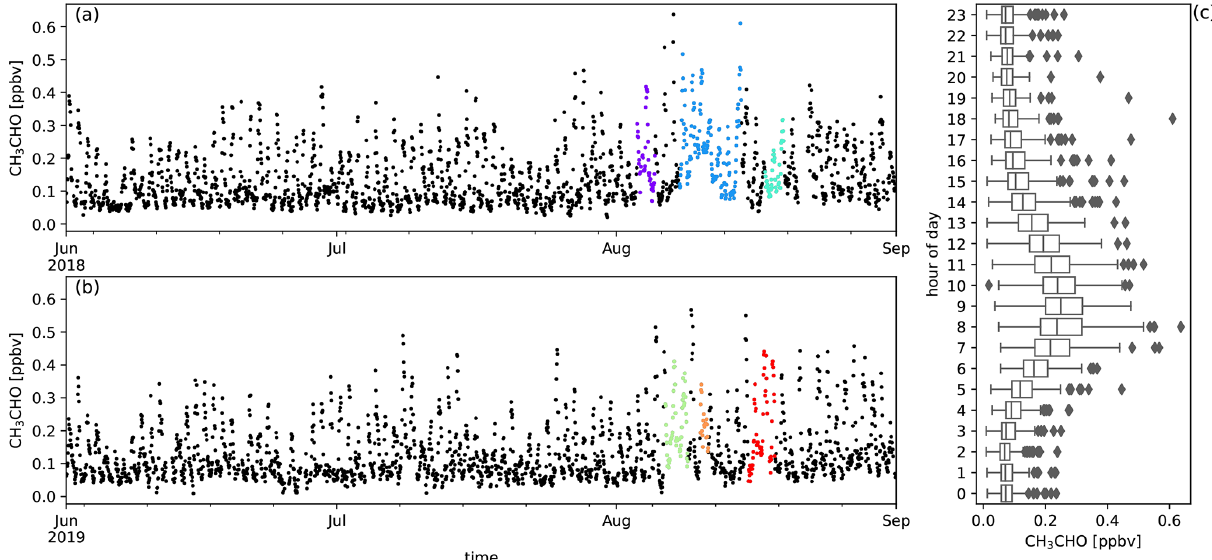
Figure A10. Measured CH 3 CHO mixing ratios (ppbv) during austral winter 2018 (a) and austral winter 2019 (b) together with the diel distribution of hourly averages (c) . Biomass burning plumes under investigation are highlighted in colours.